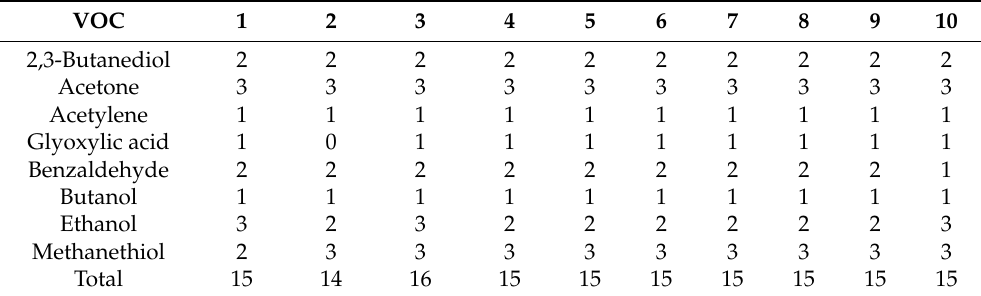
Table 5. Prediction of volatile organic compounds biosynthesis genes in P. polymyxa